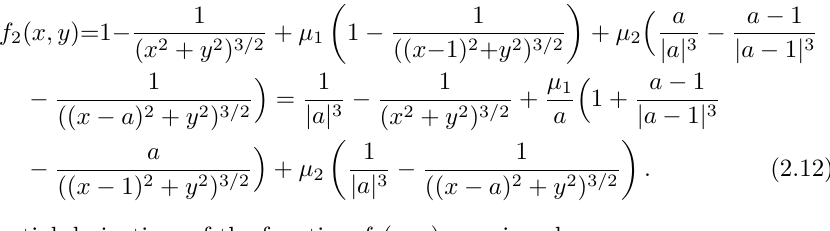
for any x ∈ [0 , 2] there exists only one value of y inside of the interval bounded by the circles for which f 1 ( x, y ) = 0. For the points on the axis Ox , where y = 0 and x increases from x = 2 to x = 2 a , equation (2.10) gives ∂f 1 /∂x > 0. So function f 1 ( x, 0) increases monotonically and takes values of different signs at the boundary points x = 2 and x = 2 a . Therefore, there exists only one point x 0 ∈ (2 , 2 a ) for which f 1 ( x 0 , 0) = 0, and f 1 ( x, 0) > 0 if x ∈ ( x 0 , 2 a ].